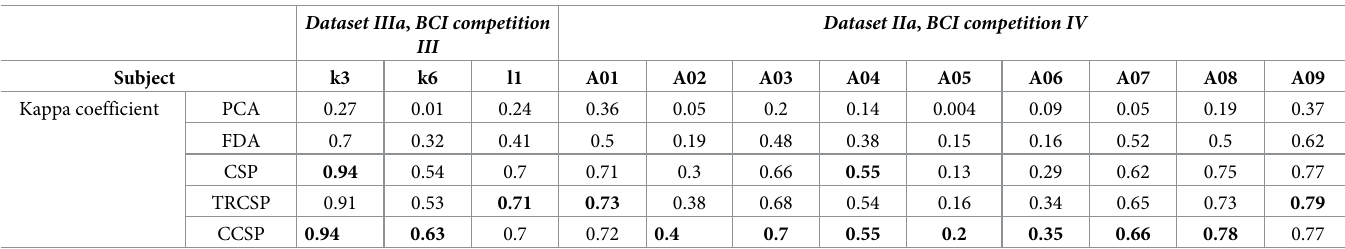
Table 3. Kappa coefficient for dataset IIIa, BCI competition III and dataset IIa, BCI competition IV in multi-class problem (Best values are in